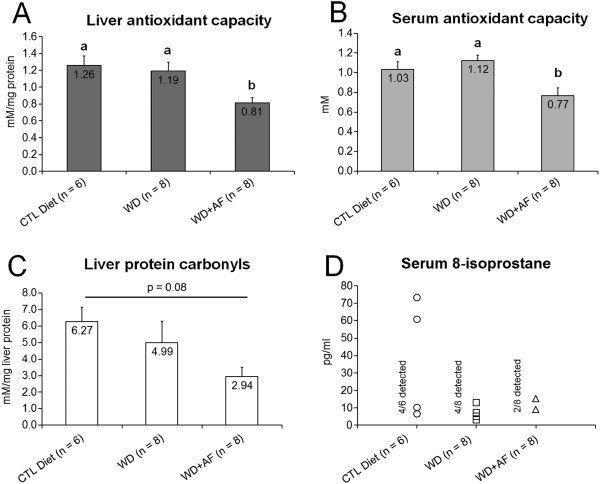
Markers of antioxidant capacity and oxidative stress following the feeding intervention. WD + AF rats experienced a decrease in liver (A) and serum total antioxidant capacity (B), although there was a paradoxical tendency for liver protein carbonyls to decrease in WD + AF rats (C). Only 25% of WD + AF rats presented detectable levels of serum 8-isoprostane, a marker of systemic oxidative stress, whereas 50 and 66% of the WD and CTL animals presented detectable levels of this marker (D). Abbreviations and symbols: CTL = control low-fat/low-sugar 14% diet, WD = Western diet, WD + AF = Western diet + anti-inflammatory supplement; In A/B, different superscript letters represents differences between groups (a > b, p < 0.05).